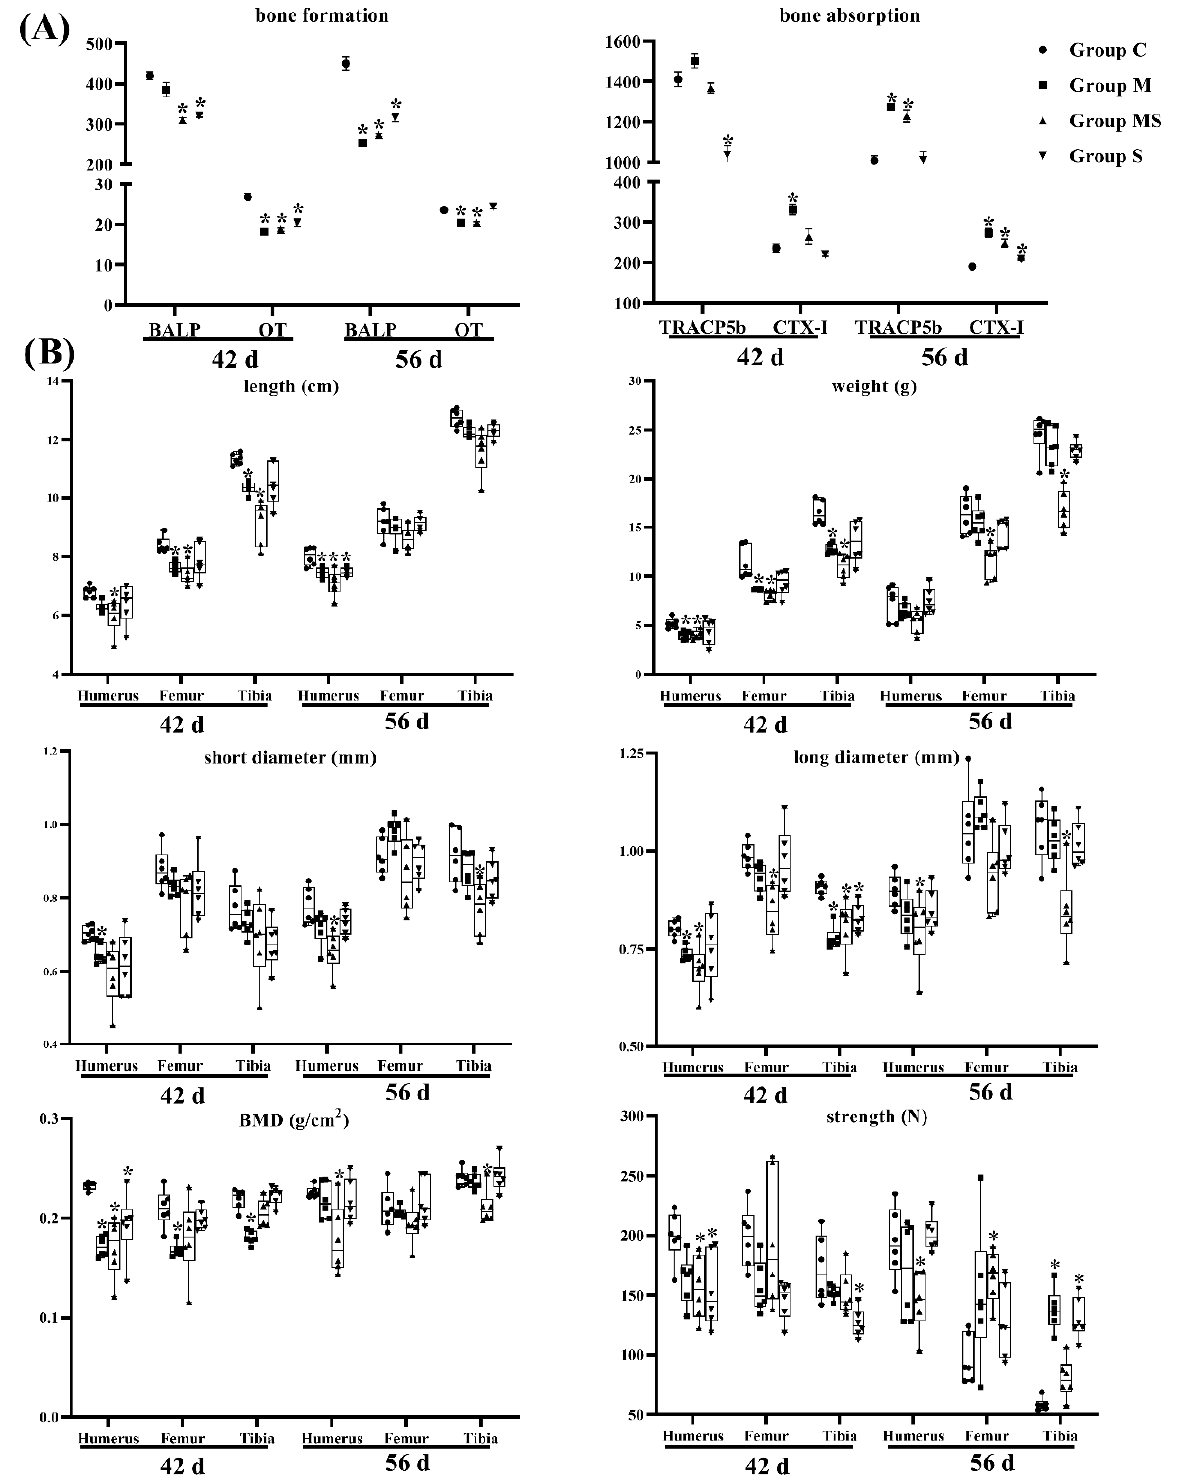
Figure 2. The changes in bone remodeling in broilers ( n = 6). ( A ) The changes in serum indicators related with bone metabolism in broilers. ( B ) The changes in bone parameters in broilers. Here, * p < 0.05 vs. the control group.